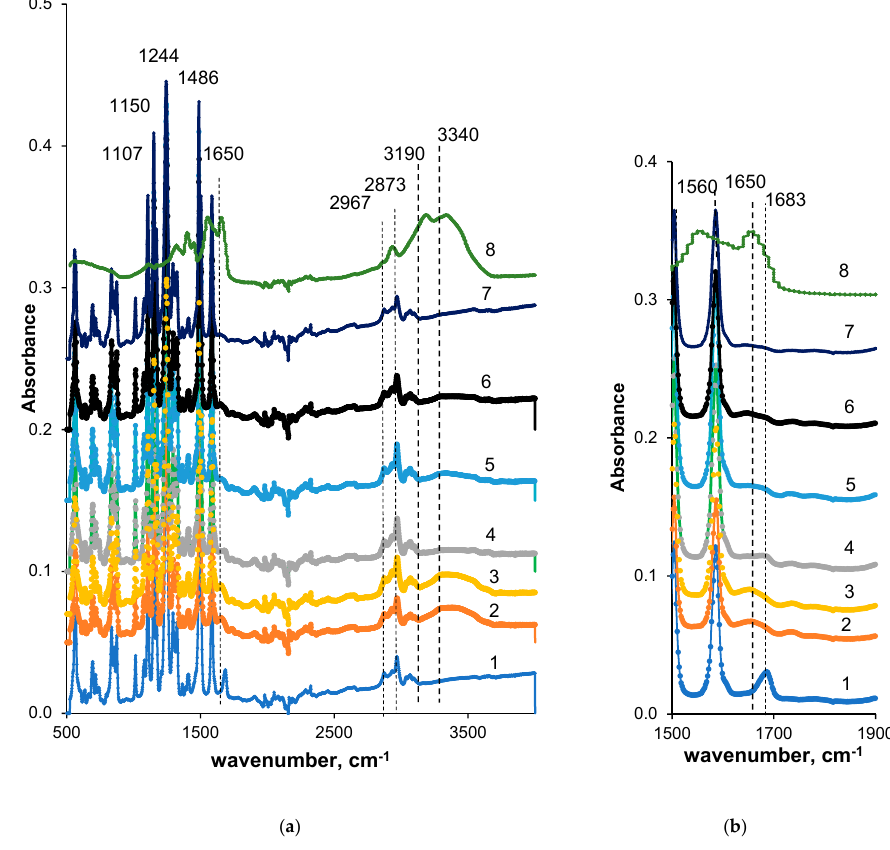
Figure 4. FTIR spectrum ( a ) and fragment of the spectrum ( b ) of the PSF membrane skin (2–5) and bottom (6, 7) layer; PASA concentration in the coagulant, wt %: 1—0, T = 60 °C (A60); 2—0.2, T = 60 °C (A-0.2-60); 3—0.2, T = 25 °C (B-0.2-25); 4—0.3, T = 60 °C (A-0.3-60); 5—0.3; T = 25 °C (A-0.3-25); 6—0.2, T = 60 °C, bottom layer (A-0.2-60); 7—0.2, T = 25 °C (A-0.2-25), bottom layer; 8—PASA powder.